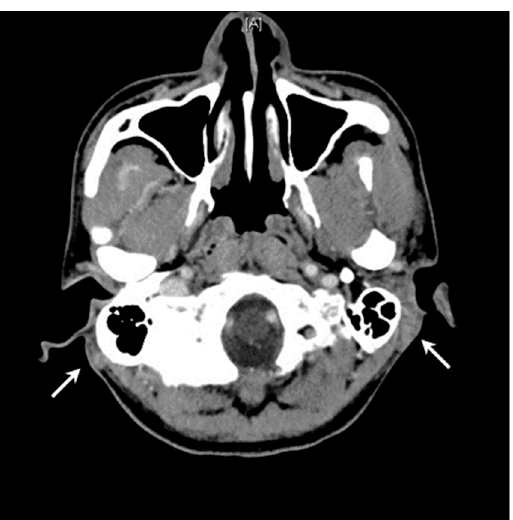
Figure 2. High-resolution computed tomography with head and upper neck enhancement in Case 2. The image revealed subcutaneous nodular lesions (arrows) in the bilateral postauricular region (dimensions, right: 15 mm × 7 mm; left: 17 mm × 12 mm) with relatively ill-defined margin and increased stranding of adjacent subcutaneous fat.